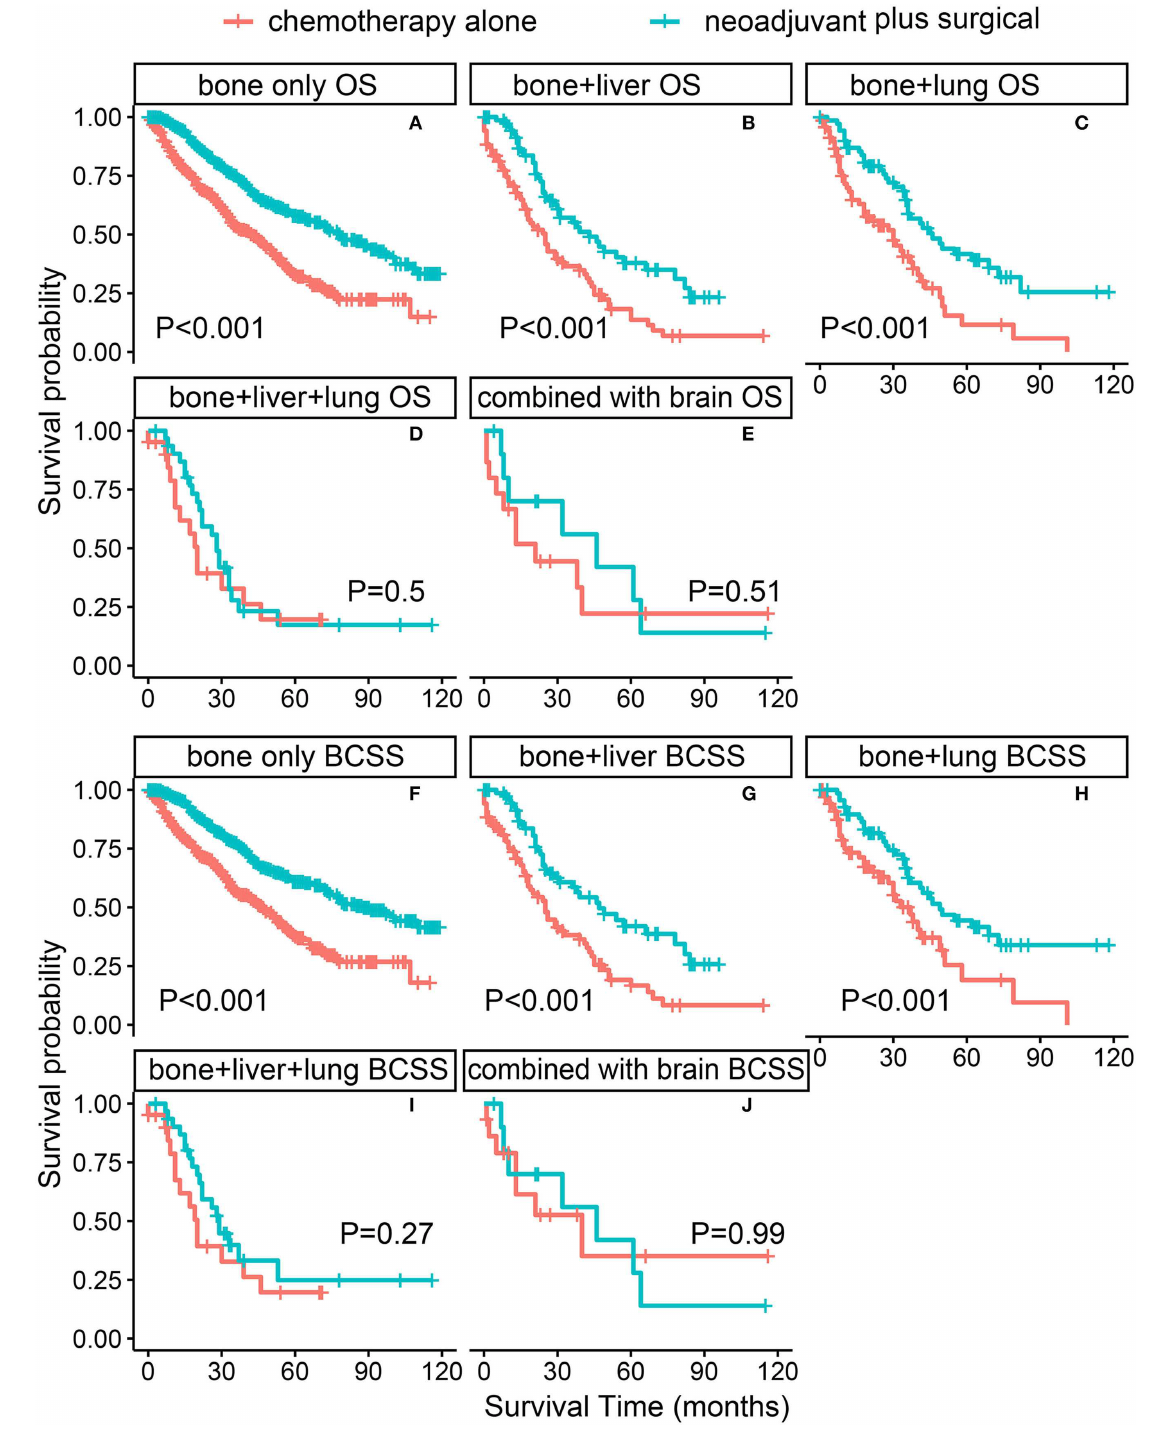
FIGURE4 PSM-adjusted OS and BCSS of patients with BMBC in the neoadjuvant chemotherapy plus surgical treatment and chemotherapy alone groups (stratified by metastatic modality). Kaplan–Meier (K–M) survival analysis: (A) OS of patients with bone metastases only; (B) OS of patients with bone and liver metastases; (C) OS of patients with bone and lung metastases; (D) OS of patients with bone and liver and lung metastases; (E) OS of patients with BMBC combined with brain metastases; (F) BCSS of patients with bone metastases only; (G) BCSS of patients with bone and liver metastases; (H) BCSS of patients with bone and lung metastases; (I) BCSS of patients with bone and liver and lung metastases; (J) BCSS of patients with BMBC combined with brain metastases. OS, overall survival; BCSS, breast cancer-specific survival; PSM, Propensity score matching; BMBC, bone metastatic breast